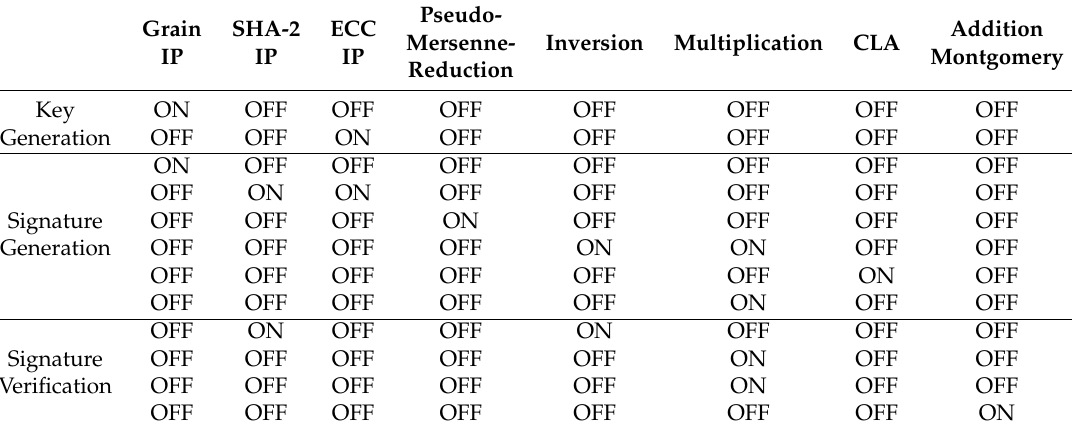
Table 7. ECDSA IPs methodology